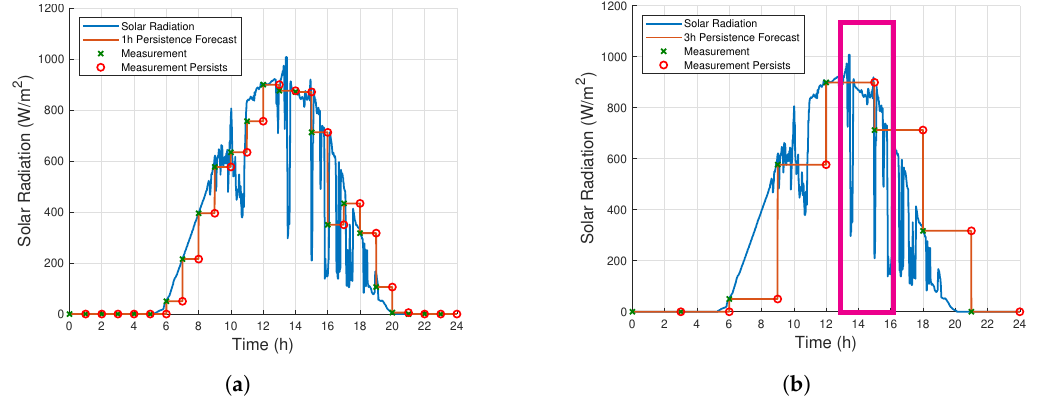
Figure 7. A 1 and 3 h PWF for solar irradiance over a 24 h period. ( a ) A 1 h PWF for the solar irradiance, which is broken into 24 evenly spaced forecast intervals. ( b ) A 3 h PWF for the solar irradiance, which is broken into 8 evenly spaced forecast intervals.